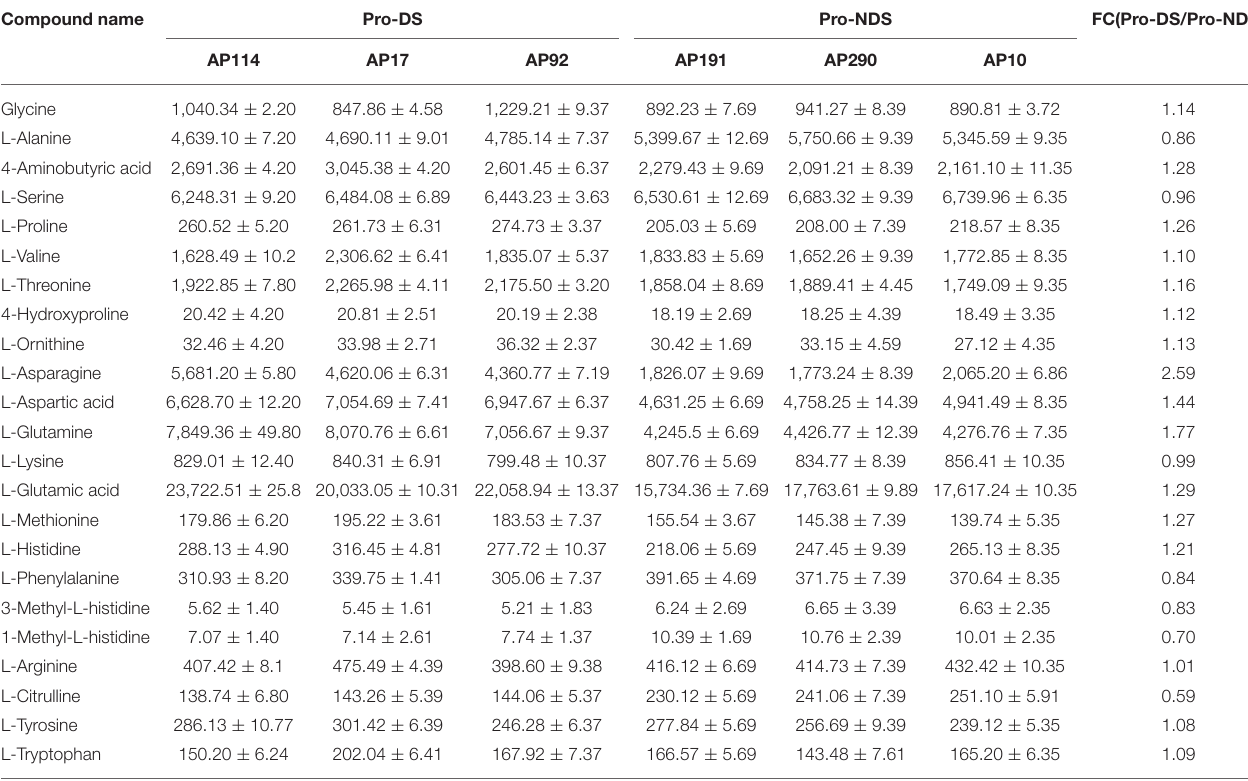
TABLE 1 | Contents of amino acid in rice under salt